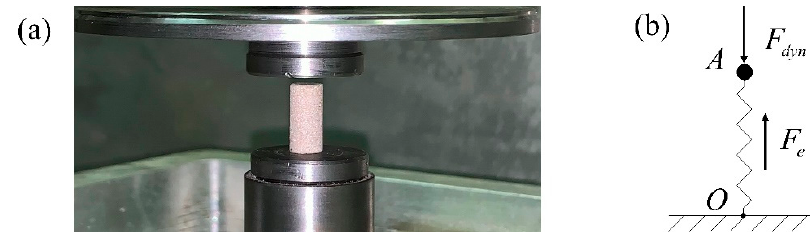
Figure 5. The “mass ‐ on ‐ a ‐ spring” model: ( a ) a sample in the set ‐ up; ( b ) schematics of the model. Figure 5. The “mass-on-a-spring” model: ( a ) a sample in the set-up; ( b ) schematics of the model. The displacement of a mass 𝑢 (cid:3404) 𝑢(cid:4666)𝑡(cid:4667) from an equilibrium position specifies changes in a The displacement of a mass u = u ( t ) from an equilibrium position specifies changes in a